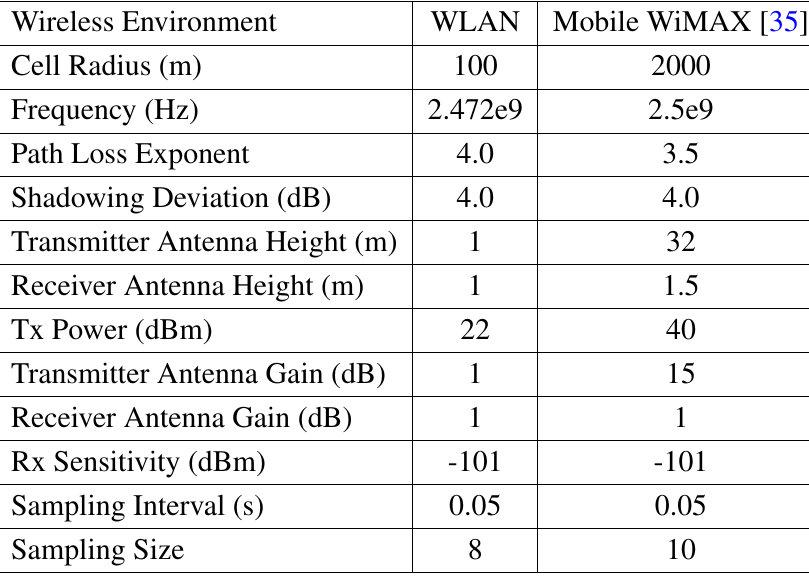
Table 2. Default parameters for radio propagation.